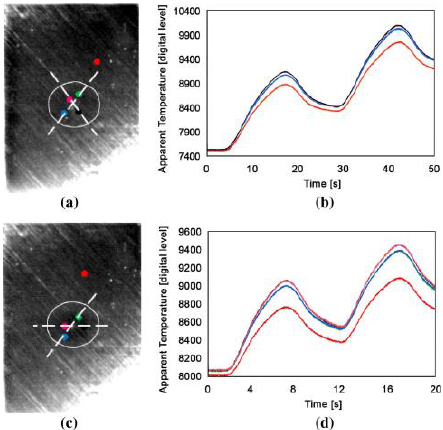
Figure 13. Ultrasonic lock-in thermography results on a composite panel with BVID, with permission from. Figure ( a , c ) shows the lock-in results with delamination at − 45 ◦ and +/ − 45 ◦ , and − 45 ◦ and 90 ◦ respectively, whilst figure ( b , d ) illustrates the apparent temperature results at 0.04 Hz and 0.1 Hz, respectively. [110].